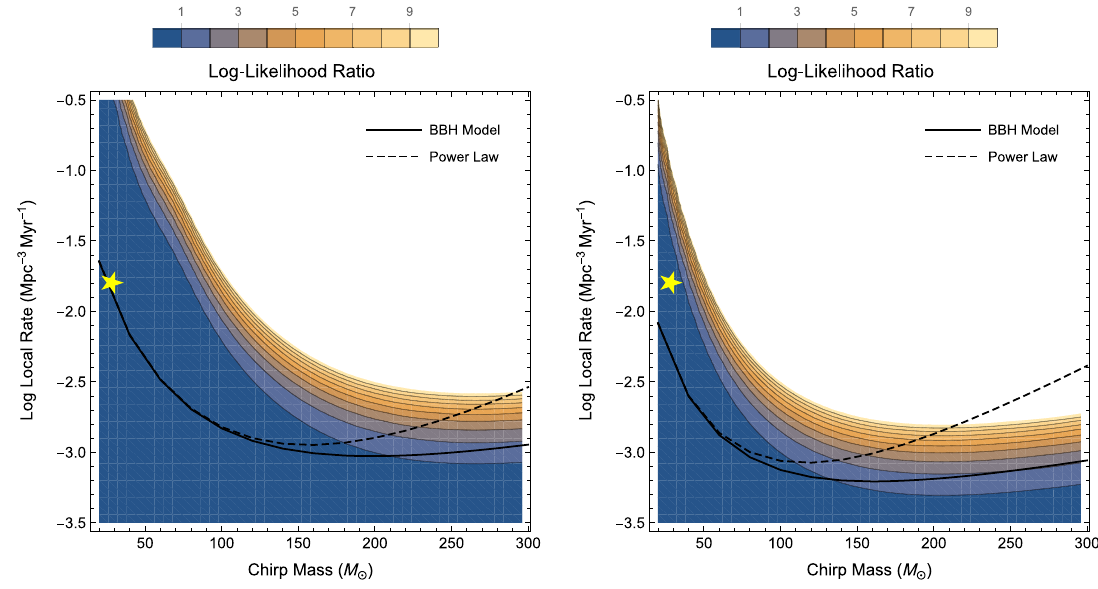
FIG. 3. Contours of maximum log-likelihood ratios ln R between the Fiducial and power-law background models [Eqs. (3) and (7), respectively] for Advanced LIGO (H1-L1) (left) and colocated detectors (H1-H2) (right), as a function of the background ’ s average chirp mass and local coalescence rate. The results shown assume three years of integration time at design sensitivity. The solid and dashed black curves indicate the local coalescence rates at which a BBH background is detectable with SNR ¼ 3 after three years when assuming the Fiducial and power-law models, respectively, and the star indicates the background associated with GW150914 [15]. Although the background inferred from GW150914 may be marginally detectable with Advanced LIGO after three years of observation, it is indistinguishable from a simple power-law model. The background remains indistinguishable from a power law even for colocated detectors, which are predicted to make a strong detection of the BBH